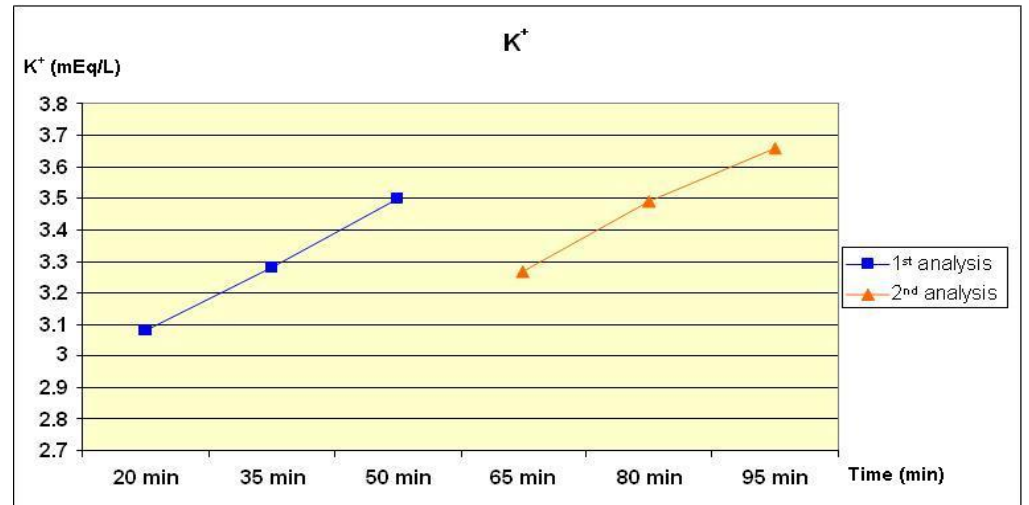
FIGURE 4 – K + average values in the first and second gasometrical analysis during the blood storage on ice